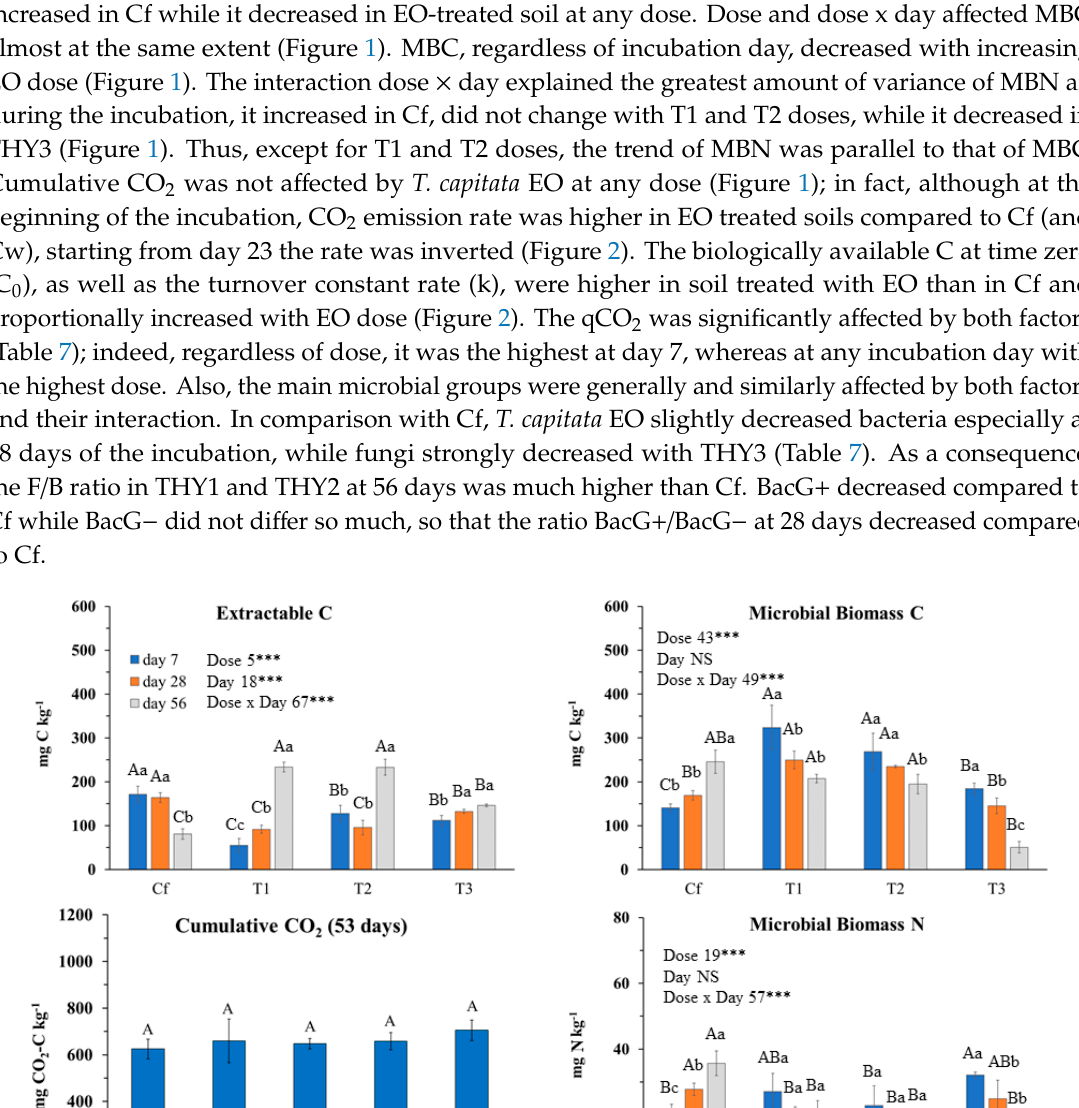
Figure 1. Biochemical soil variables determined at 7, 28 and 56 incubation days after Thymbra capitata L. (Cav) essential oil applied by irrigation at di ff erent doses: Cw (no Fitoil and EO application), Cf (0.03 µ L Fitoil g − 1 of soil and no EO application), T1 (0.03 µ L Fitoil g − 1 of soil and 0.31 µ L EO g − 1 of soil), T2 (0.03 µ L Fitoil g − 1 of soil and 0.67 µ L EO g − 1 of soil), and T3 (0.03 µ L Fitoil g − 1 of soil and 0.93 µ L EO g − 1 of soil). Reported results are means ± standard deviations ( n = 4). The percentage of variance explained by incubation day, dose of essential oil and by their interaction are also reported. Capital letters indicate significant di ff erences among doses within the same incubation day. Lower case letters indicate significant di ff erences among incubation days within the same dose. *** indicate significant at p < 0.001; NS, not